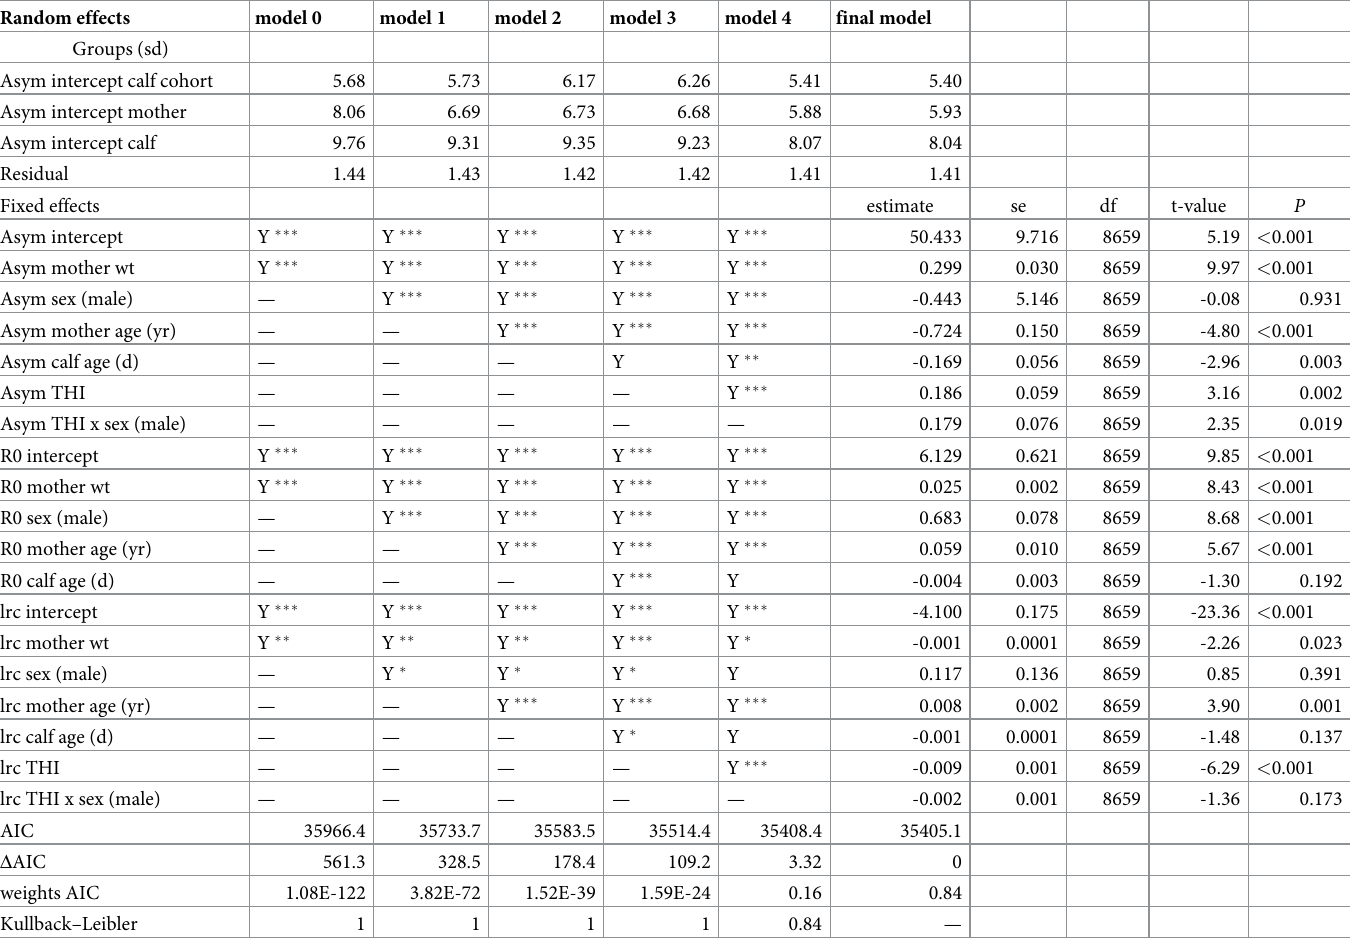
Table 2. Coefficients and statistics of an exponential asymptotic mixed linear model on calf weight (Kg) controlling for animal and a thermal stress index (THI) variables. Random